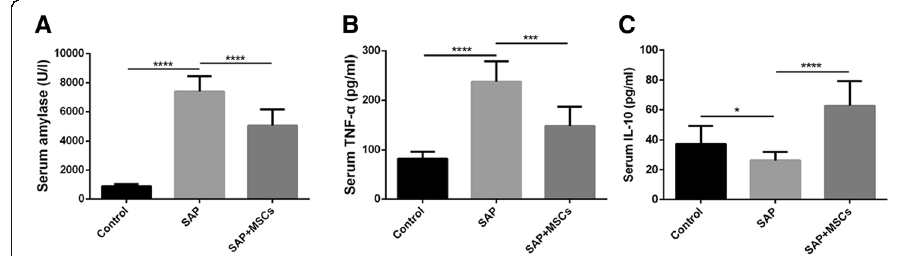
Fig. 3 MSCs attenuated the severity of systematic inflammation in SAP rats. a Serum amylase levels. b Serum TNF- α levels. c Serum IL-10 levels. * p < 0.05, *** p < 0.001, **** p <